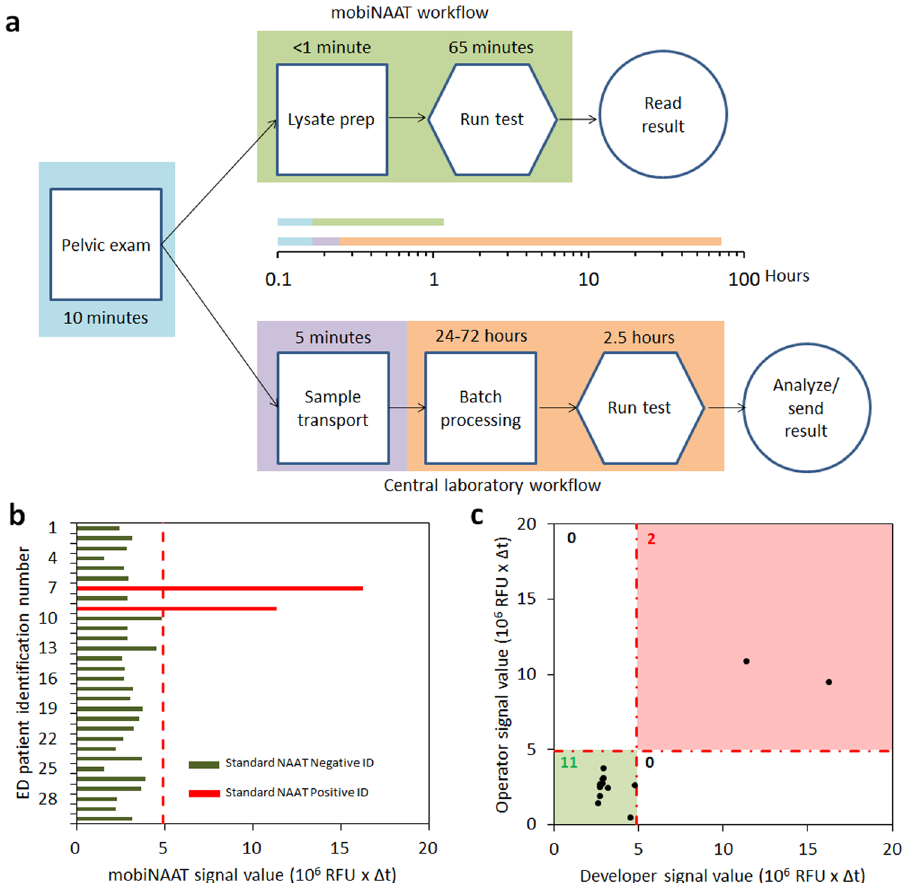
Figure 4. Platform evaluation at ED. ( a ) Comparison of standard and mobiNAAT workflows in the emergency room. In a standard workflow, the vaginal swab acquired during a pelvic exam by the provider is collected by a study coordinator, who transports the sample to the microbiology laboratory. The sample is then barcoded and batch processed to be tested using the standard-of-care NAAT assay. Afterwards, the test result is made available on the electronic medical record (EMR) accessible by the provider. In the mobiNAAT workflow, the test is performed directly in the emergency room via workflow as described in Fig. 2a, and the result is made available directly on the mobile device. Standard approach via central laboratory yielded > 72 hours due to downtime inherent to batch processing, whereas mobiNAAT-enabled testing in the emergency room yields diagnostic results in approximately 1 hour. ( b ) Comparison of results obtained using the mobiNAAT platform using clinical samples collected at the emergency room (n = 30). Samples were tested in parallel using the Gen- Probe Aptima Combo 2 assay for verification (positives marked by red bars; negatives marked by green bars; instrument data in Fig. S8). Among all patient samples tested, two patients (ID 7 and 9) reported positive in the verification assay, in agreement with the result obtained using the mobiNAAT platform. Classification threshold (red dotted line) is established using signals obtained from a set of control negative samples (n = 15) (Fig. S9). ( c ) Comparison of results obtained using mobiNAAT platform by the developers and a naïve operator trained using the mobile app (n = 13). Patients 5–17 were tested in parallel by a clinical staff member at the emergency room (green markers) and showed full correspondence with the results obtained by the developers (11 negative, 2